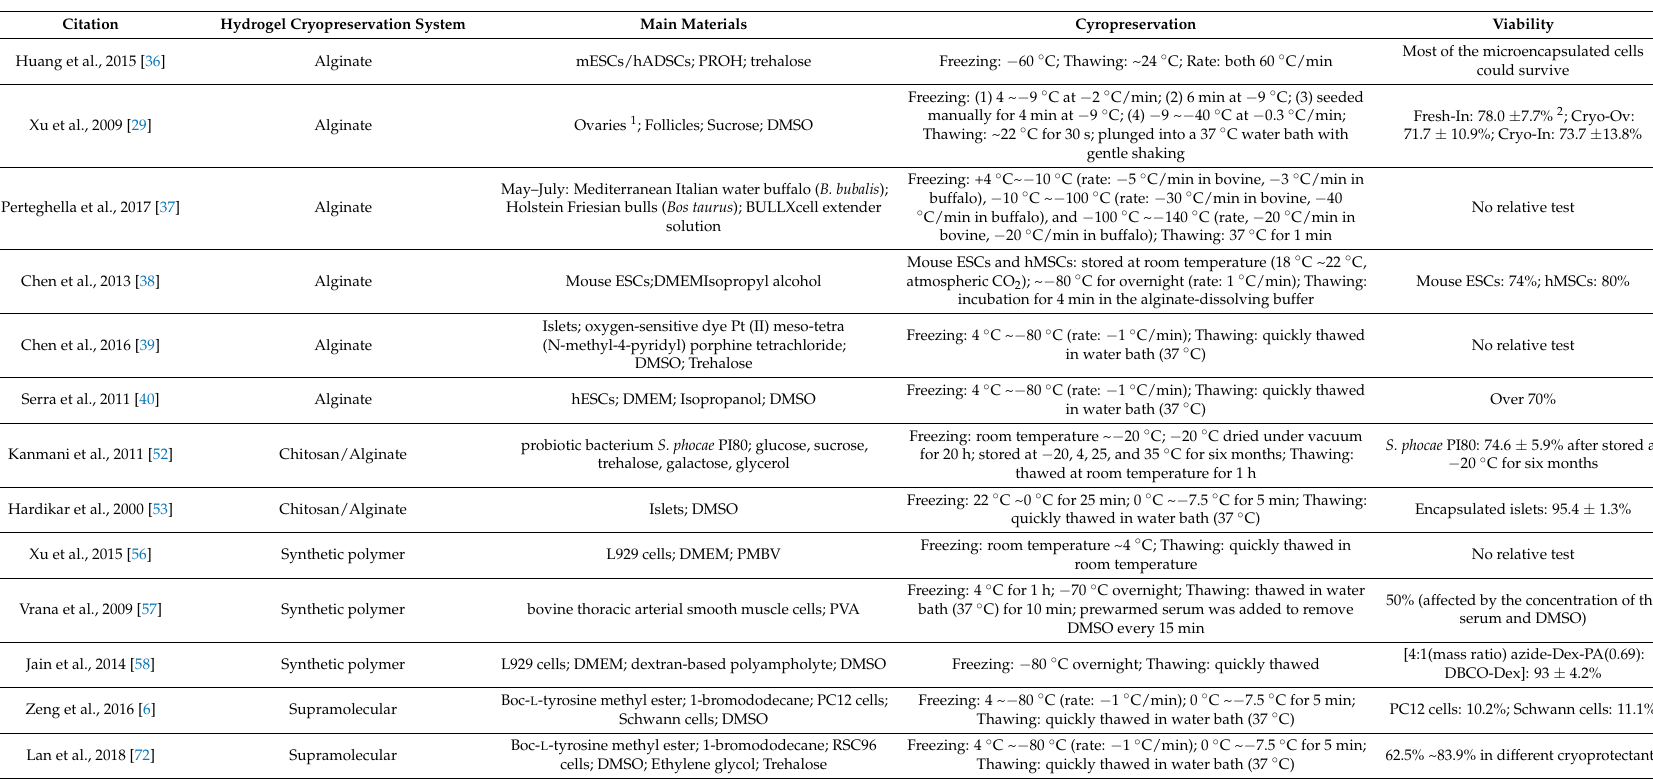
Table 1. Articles reporting on natural polymer hydrogel, synthetic polymer hydrogel, and supramolecular hydrogel cryopreservation